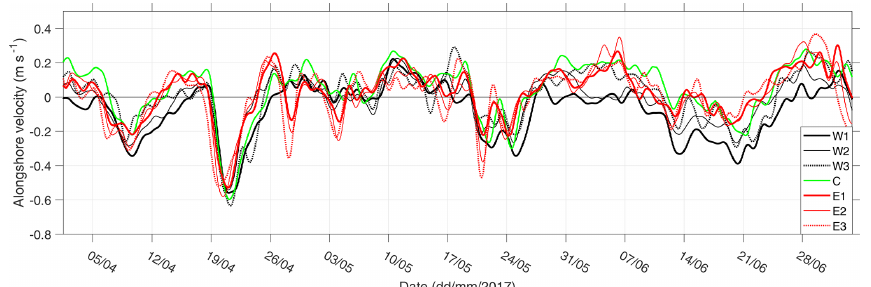
Figure 12. Alongshore velocities at the seven selected nodes. See Fig. 1 for location. Alongshore velocities are obtained from the angle of maximum variance of velocity vectors at each node.